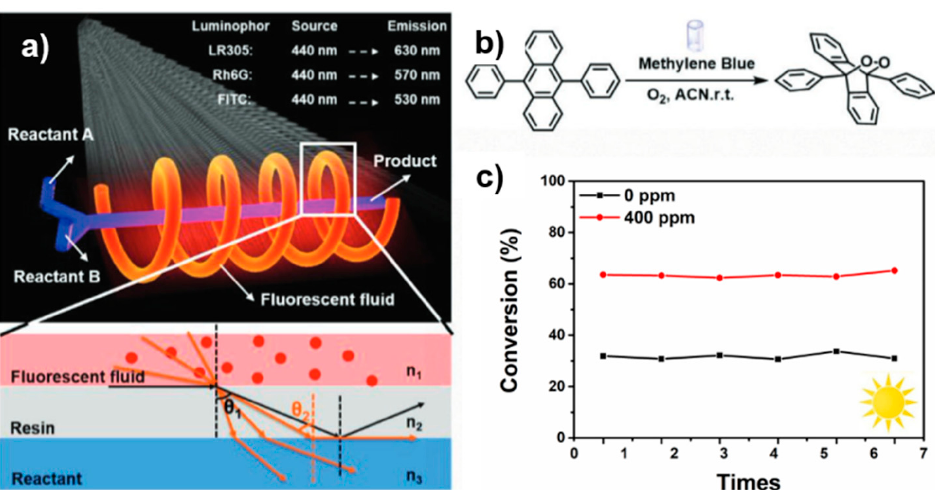
Figure 4. ( a ) Schematic of the modified LSC-PM device based on a coil containing a fluorescent fluid wrapped around the reaction channel. ( b ) The cycloaddition of DPA to the endoperoxide is used as the reaction model to evaluate the performance of the LSC-based reactor. ( c ) Conversion rate for the liquid-based LSC-PM under 1.0 sun (400 ppm of LR305, 15 s residence time); reprinted with permission from Ref. [40]. Copyright 2019 John Wiley & Sons.